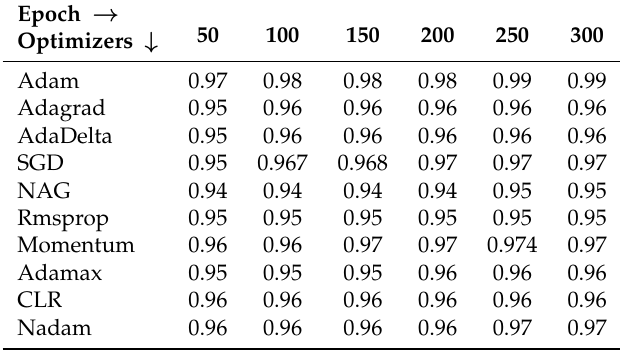
Table 6. Validation accuracy of ten optimizers on a proposed patch-wise model architecture of CNN. Epoch → 50